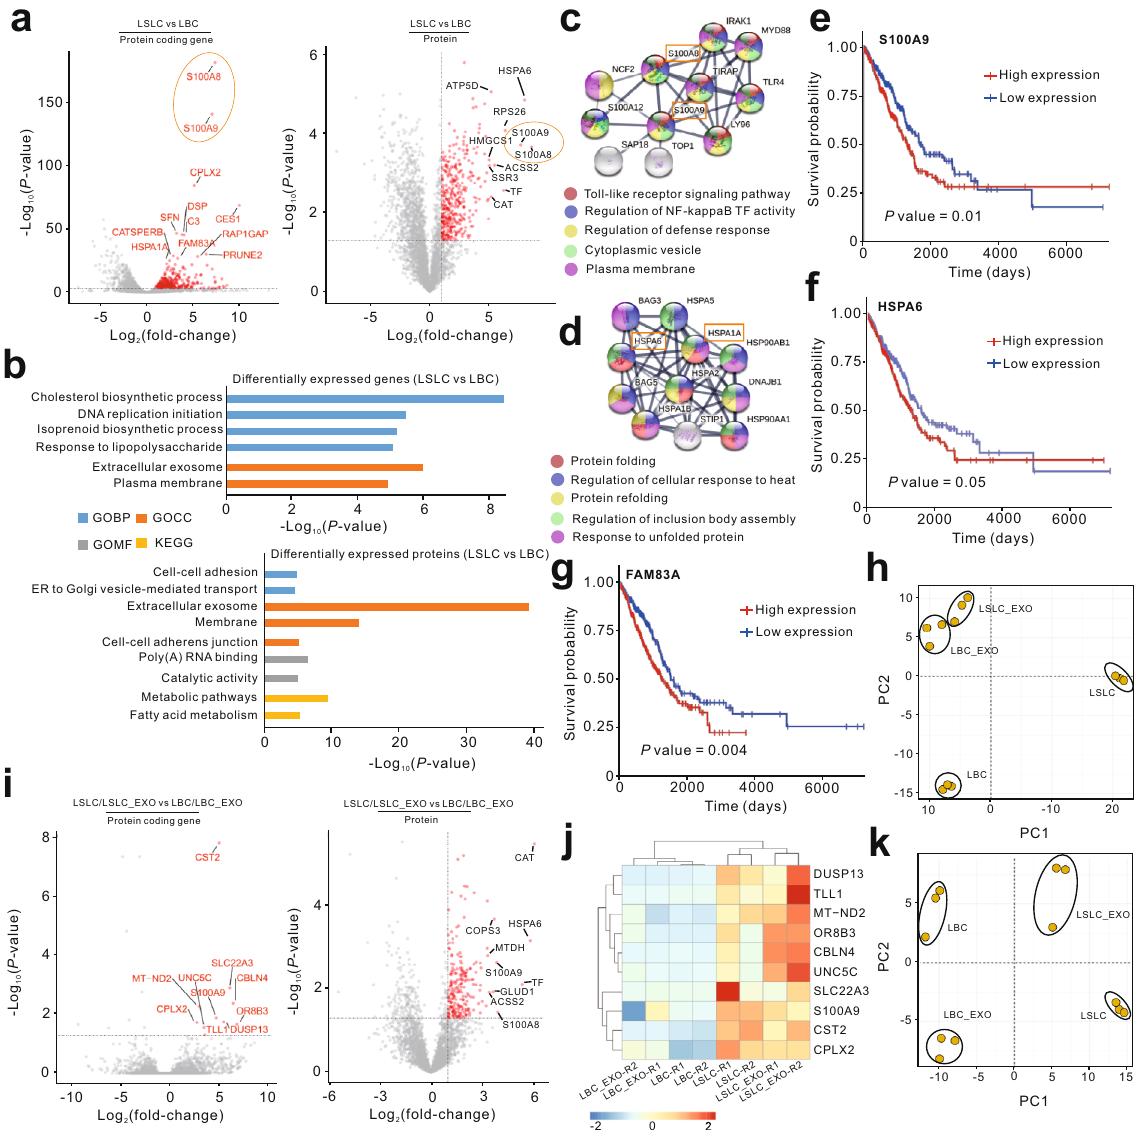
Fig. 7 Functional and clinical signi fi cance of LSLC markers. a Volcano plots showing LSLC markers identi fi ed using transcriptomic (left panel) and proteomic (right panel) data. Red dots denote the genes passing P value and fold difference thresholds. The common genes between transcriptomic and proteomic data are circled. b Functional annotation of LSLC markers from transcriptomic (top panel) and proteomic (bottom panel) data. c , d The PPI subnetwork of representative LSLC markers obtained from the STRING database. The signi fi cant enriched gene annotations are colored. e – g The survival curves based on TCGA LUAD data showing that patients with higher expression of LSLC markers had poor prognosis. h Principal component analysis based on LSLC marker proteins. i Volcano plots showing signi fi cantly highly expressed genes in LSLC and LSLC-EXO based on transcriptomic (left panel) and proteomic (right panel) data. j Heatmap showing the signi fi cantly highly expressed genes in LSLC and LSLC-EXO at the transcriptomic level. k Principal component analysis based on signi fi cantly highly expressed proteins in LSLC and The intercellular communications between LSLCs and LBCs could be partially mediated by exosomes. We reasoned that the activity, and regulation of defense response (Fig. 7c). In addition, LSLC markers that were relatively abundant in LSLC-EXO, while not the members of the heat shock protein family, including HSPA1A or lowly expressed in LBC and LBC-EXO, could server as mediators and HSPA6, whose functions were associated with protein folding/ between LSLCs and LBCs. These LSLC-EXO-transported LSLC refolding and cellular response 50 , were also identi fi ed as LSLC markers could also act as liquid biopsy biomarkers for early markers at the multi-omics level (Fig. 7a, d). According to The detection and diagnosis of lung adenocarcinoma. To identify such Cancer Genome Atlas lung adenocarcinoma (TCGA-LUAD) data, LSLC markers, we evaluated the expression patterns of all LSLC we found that multiple LSLC markers such as S100A9, HSPA6, and markers at both the transcriptomic and proteomic levels across all FAM83A were associated with a poor prognosis in lung samples. In comparison with LBC and LBC-EXO, 218 LSLC markers adenocarcinoma patients (Fig. 7e – g). PCA analysis based on LSLC were highly expressed in LSLCs and LSLC-EXO (Fig. 7i and markers exhibited the distinct clusters between LSLCs and LBCs Supplementary Data 11). For example, S100A9, which has been (Fig. 7h).